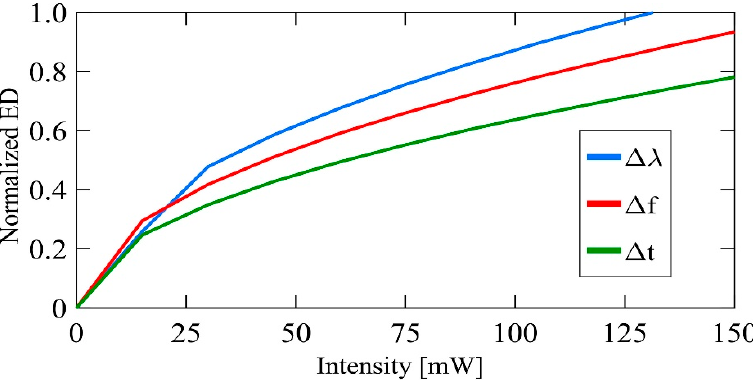
Figure 5. The plot of the mindfulness violation between the normalized electron densities (ED) and input power, where the changes in delta wavelength ( ∆ λ ), time ( ∆ t), and frequency ( ∆ f) are set as the initial state when ∆ t → 0. This is the stopping state.